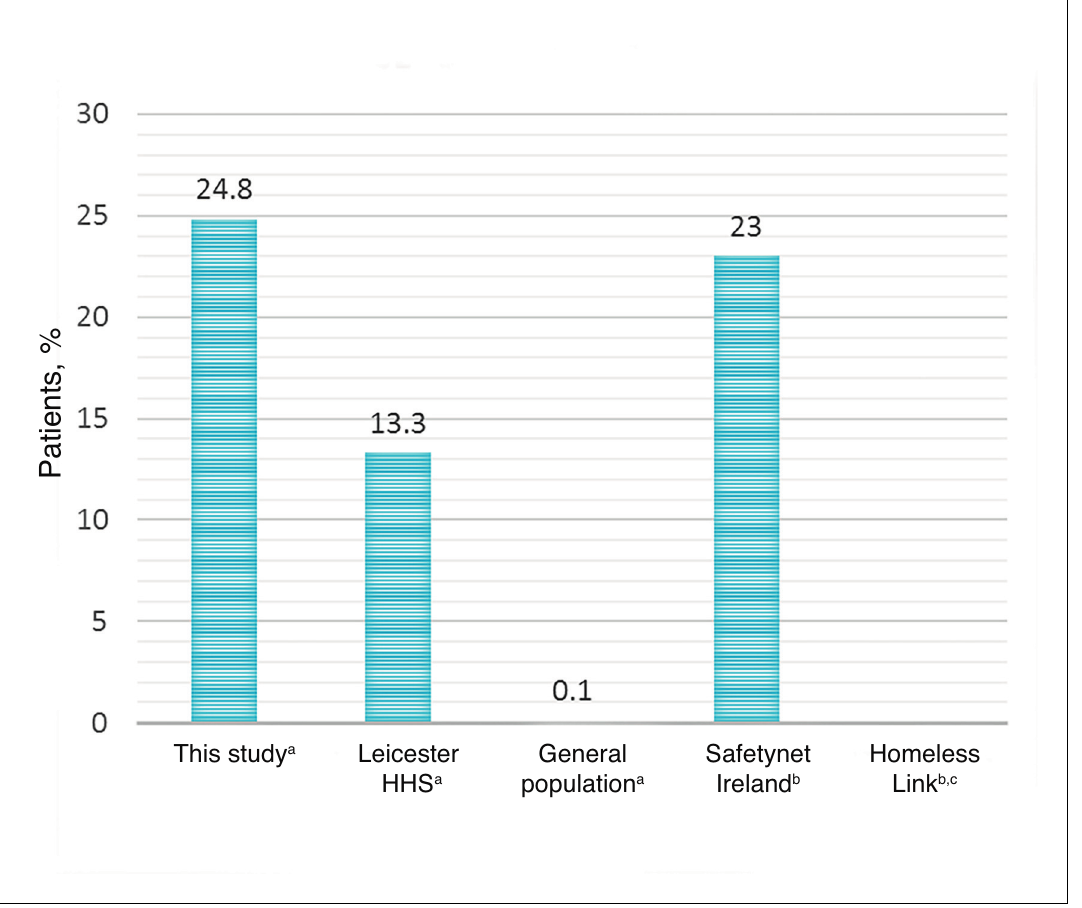
Figure 3. Prevalence of viral hepatitis C in this study versus other homeless cohorts 3,5,7 and a population-representative sample from general practice records. 8 a Clinically record data. b Self-reported data. c No data